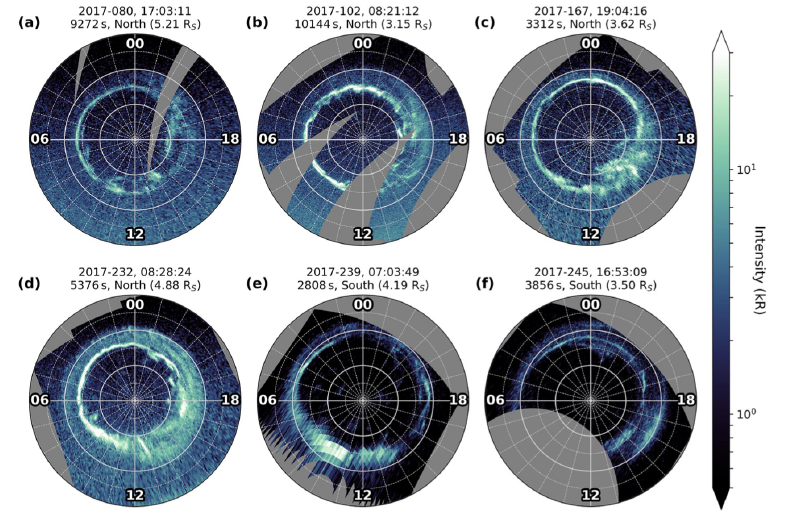
Figure 4. UVIS observations of Saturn’s northern ( a – d ) and southern ( e , f ) auroral ovals during the Grand Finale phase of the Cassini mission. Figure reproduced from Bader et al.